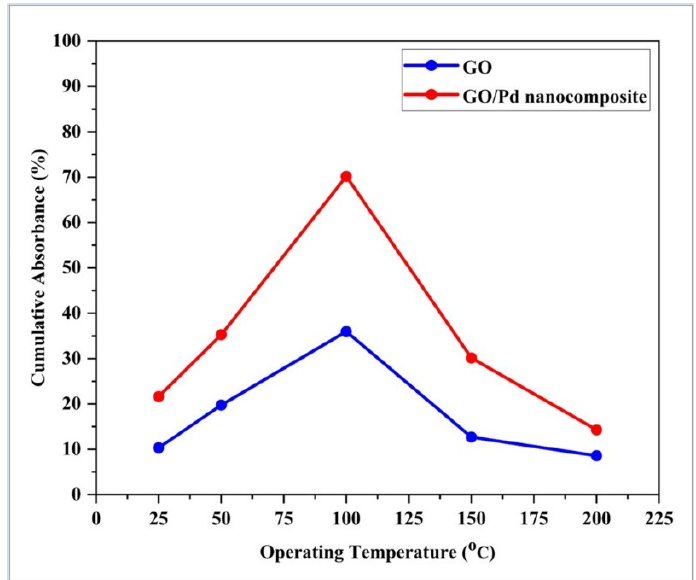
Figure 14. The change of cumulative absorption with an operating temperature of GO and Pd/GO nanocomposite-based optical fiber sensor towards synthetic air and 2.00% H 2.